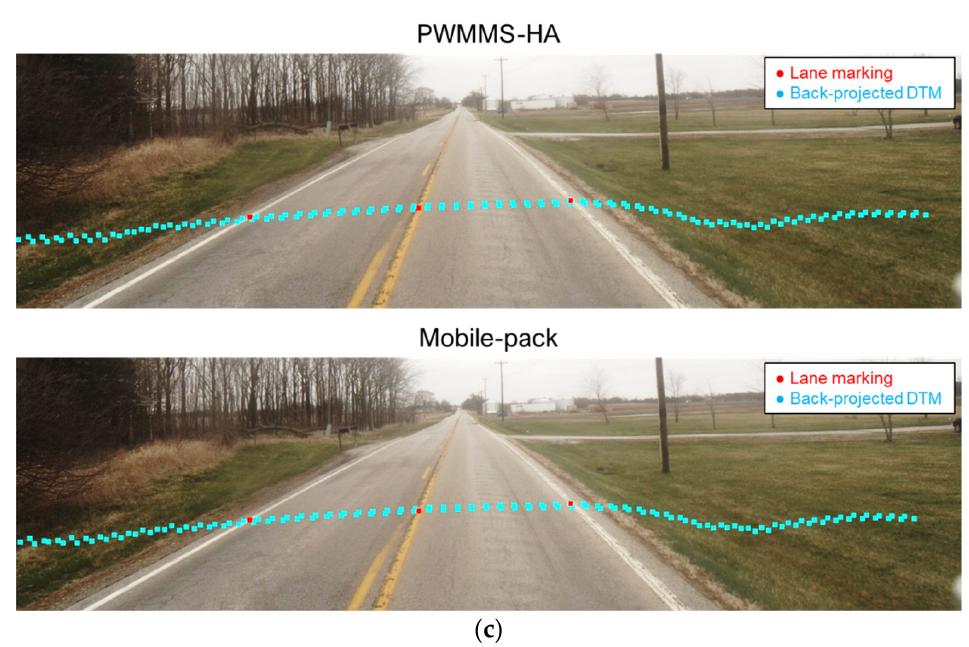
Figure 18. Cross-sectional profile at location PC2 : ( a ) point cloud and DTM profiles, ( b ) slope evaluation results together with lane marking points, and ( c ) image with back-projected DTM and lane marking points. The lane marking points are extracted from the point cloud using the approach proposed by Cheng et al. [13].